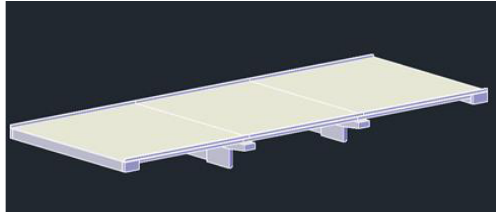
Figure 6. An overview of the BIM of Kapooka bridge.